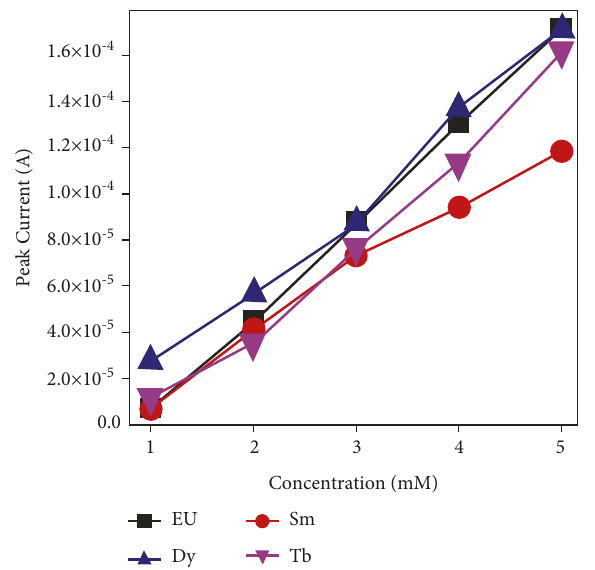
Figure 13: Peak concentration of La